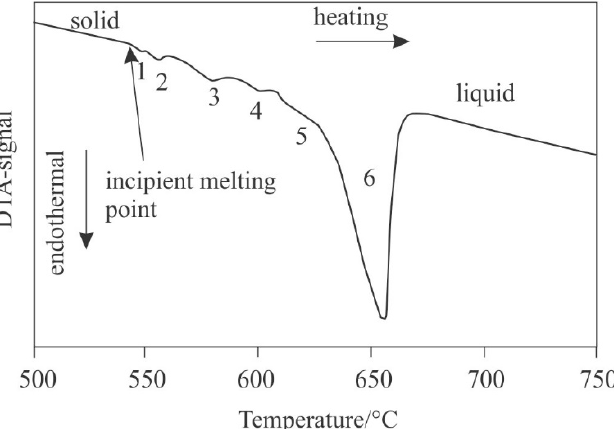
Figure 2. A section of the heating DTA-curve between 500 °C and 750 °C (the heating rate 10 °C/min, argon) showing six peaks occurring during the melting of the alloy, and that the incipient melting point lies approximately at 540 °C. point lies approximately at 540 ◦ C.